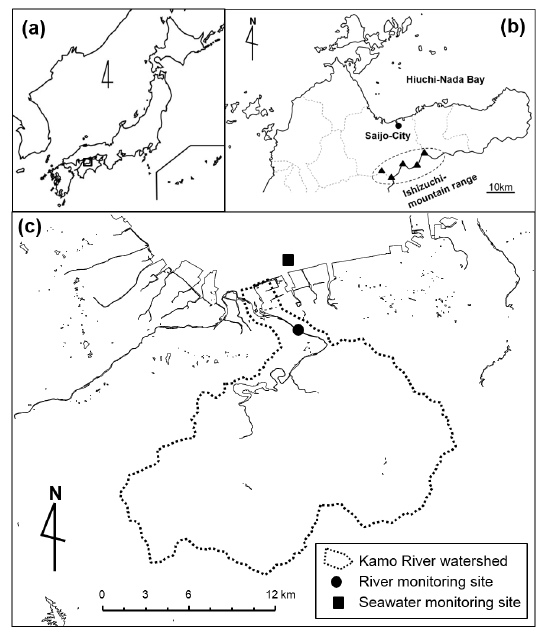
Figure 1. Location of study